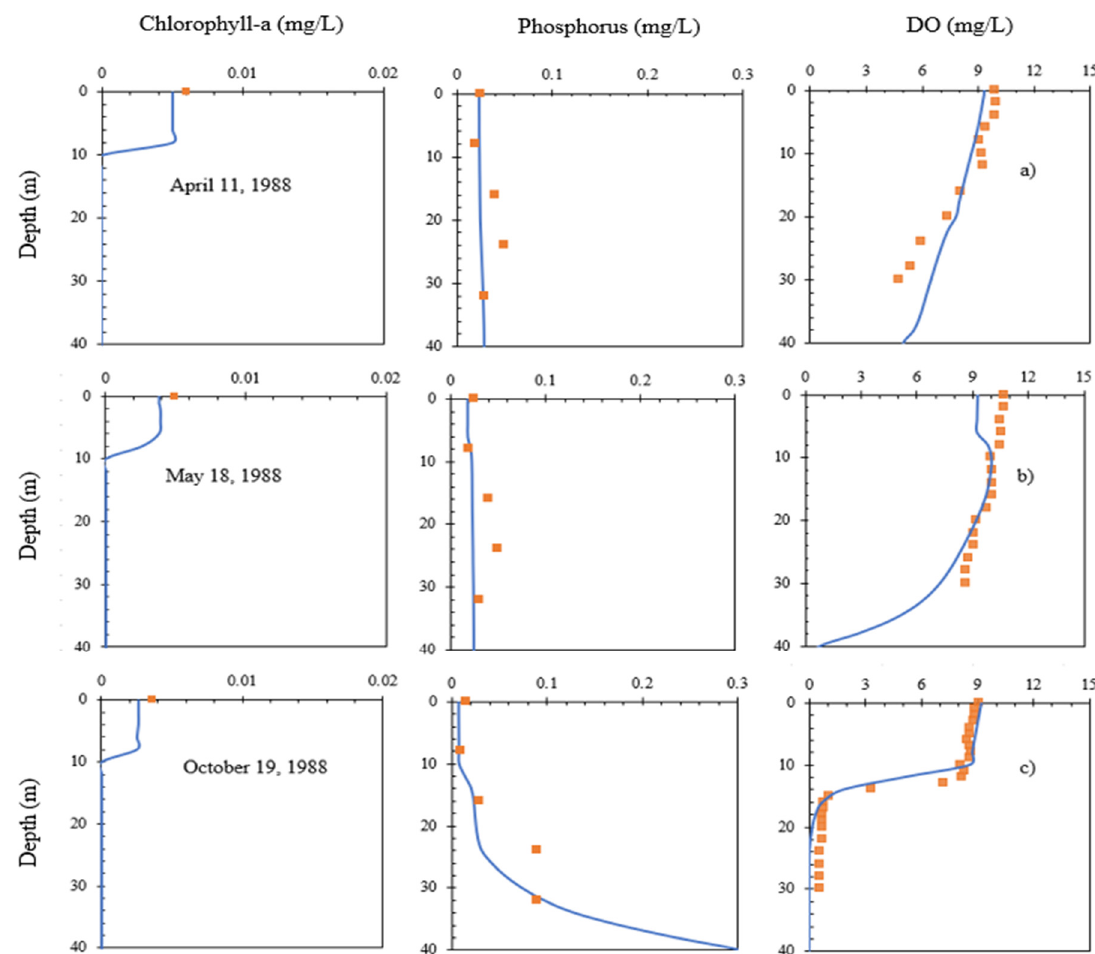
Figure 11. Simulated ( line ) and observed ( dots ) chlorophyll-a, phosphorus, and dissolved oxygen profiles for Lake Elmo on ( a ) 11 April, ( b ) 18 May, and ( c ) 19 October 1988.